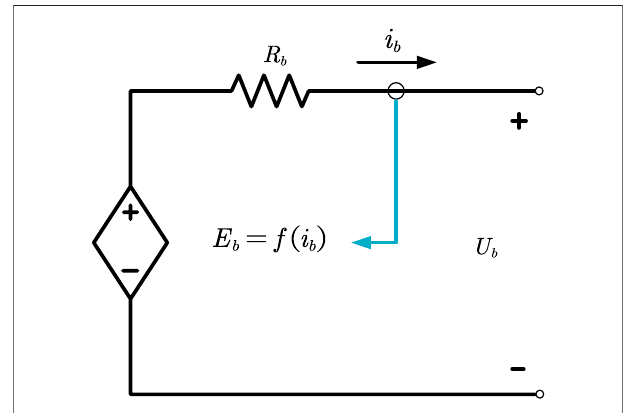
FIGURE 4 | Shepherd model circuit diagram.